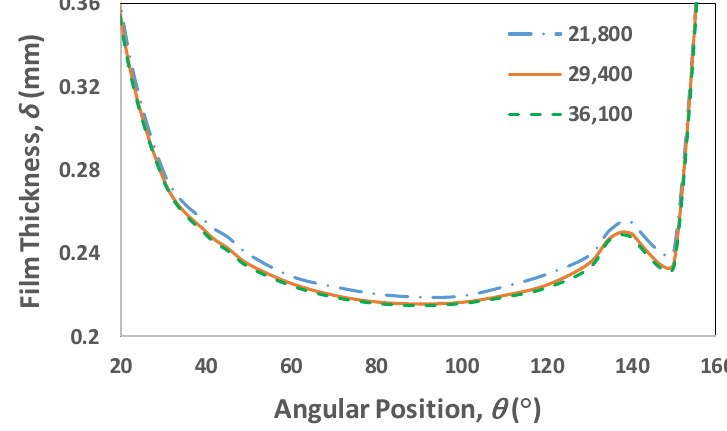
Figure 3. Film thickness distribution for Γ 1 / 2 = 0.01 kg/(m·s) and C = 0.65 at t = 2.79 s.